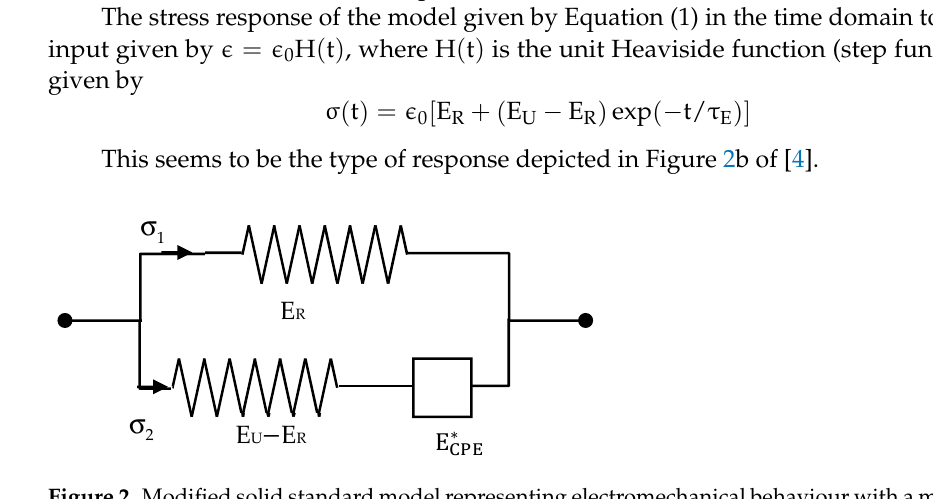
Figure 2. Modified solid standard model representing electromechanical behaviour with a mechanical constant phase element (CPE).